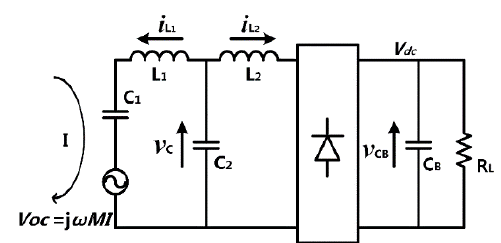
Figure 8. Simplified equivalent circuit of the